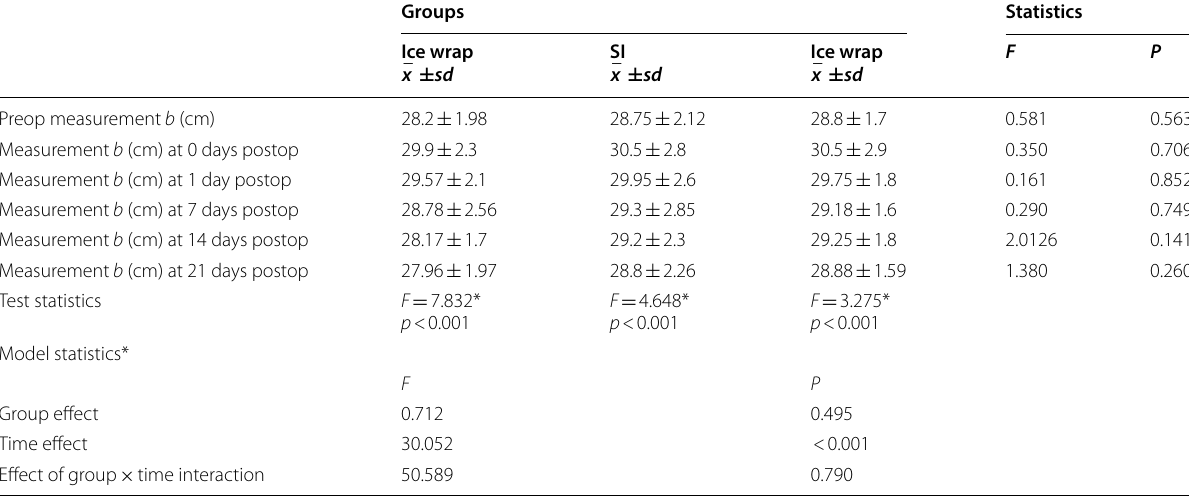
*Two-way repeated measures variance analysis; a , b , c , d , e are results of inline multiple comparison test with Bonferroni